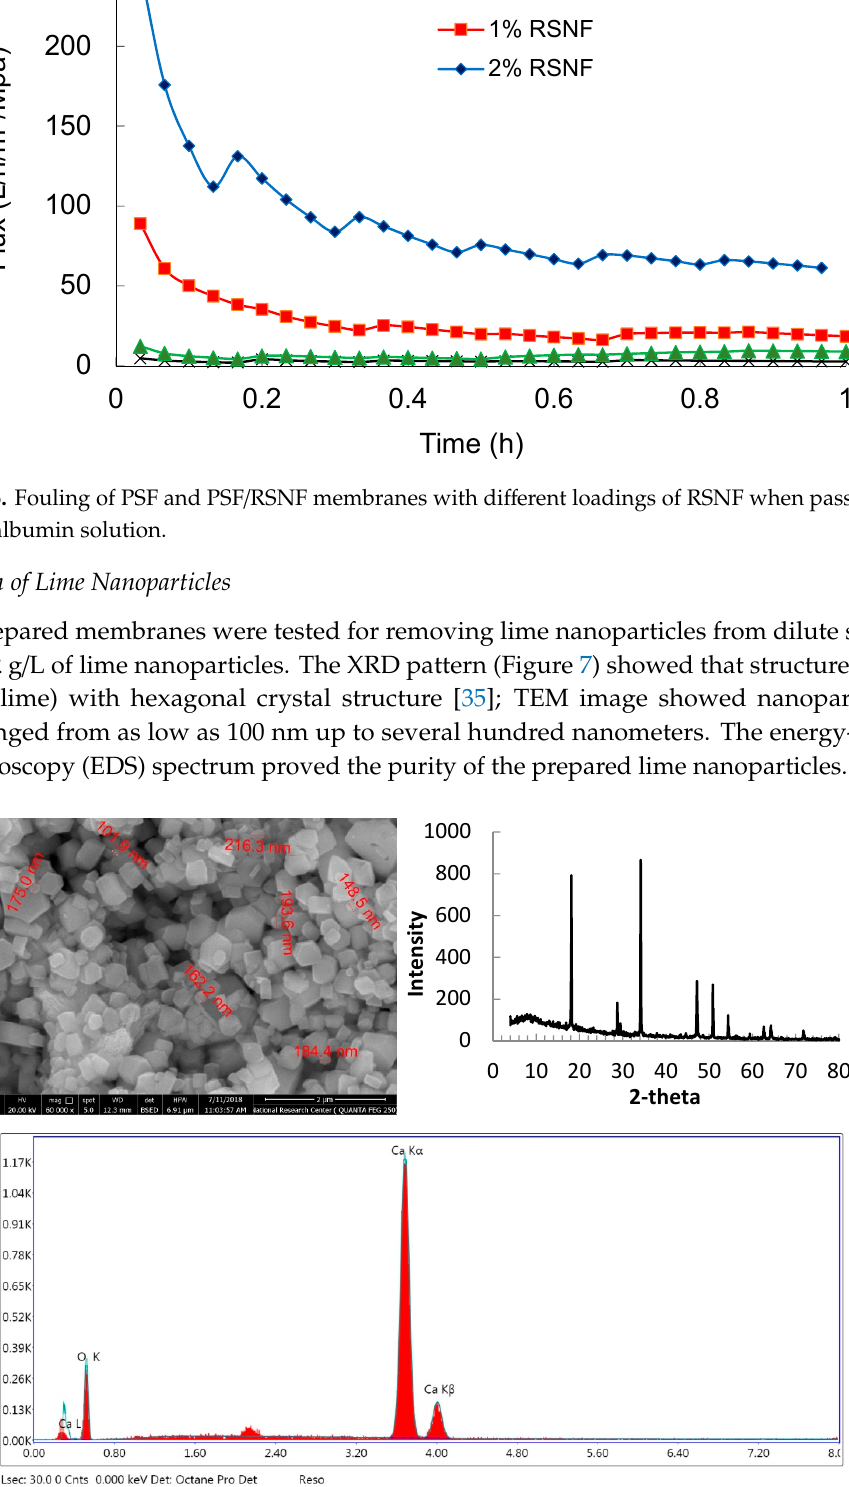
Figure 7. TEM, XRD pattern, and energy-dispersive X-ray spectroscopy (EDS) spectrum of lime